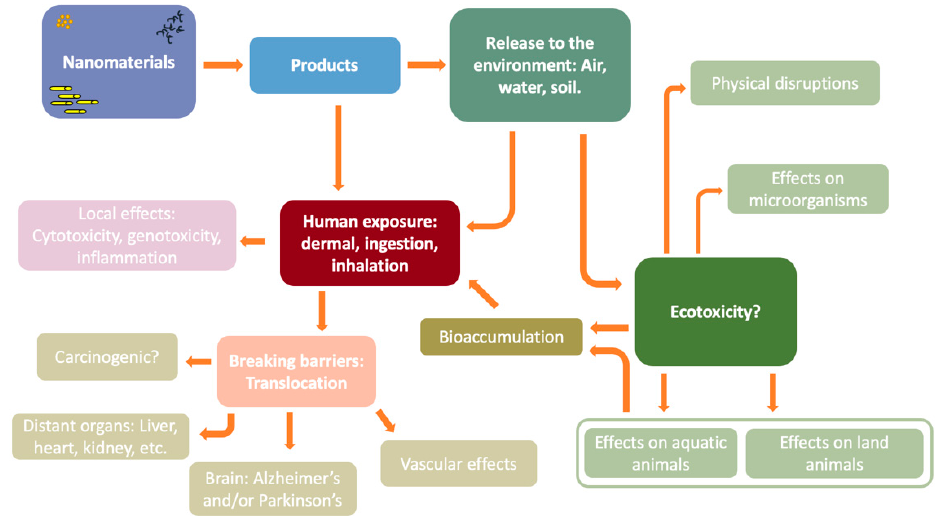
Figure 1. General view of possible interactions, routes of exposure, and adverse outcomes that can be triggered by exposure of humans and the environment to nanomaterials.